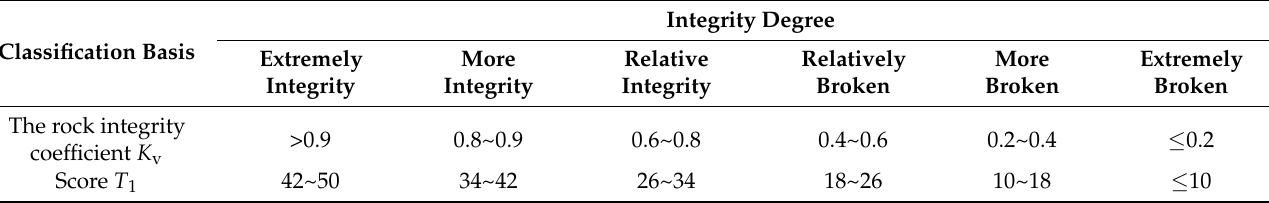
Table 6. Score of middle rock pillar integrity.